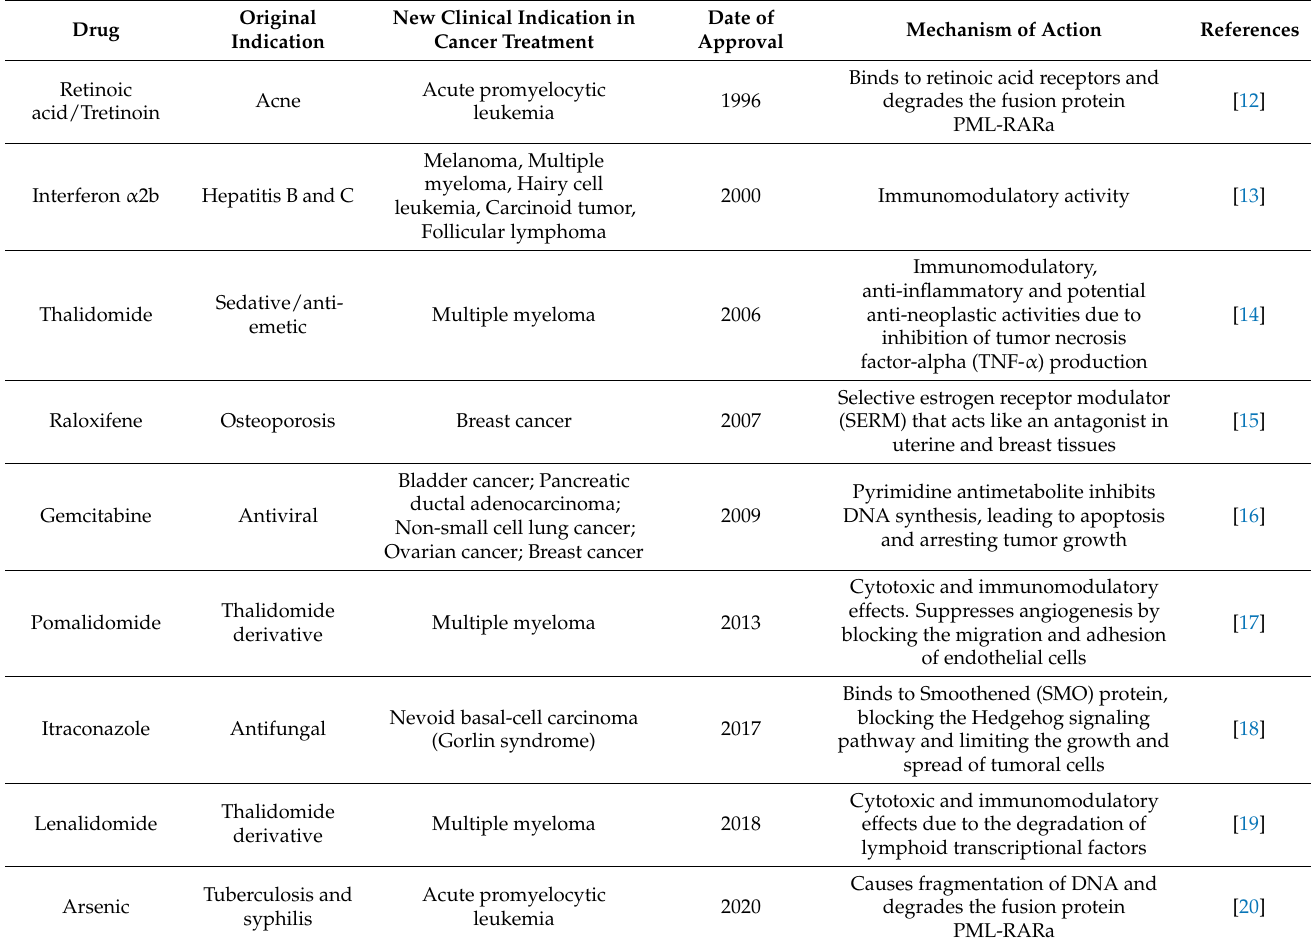
Table 1. Successful examples of drug repurposing in cancer